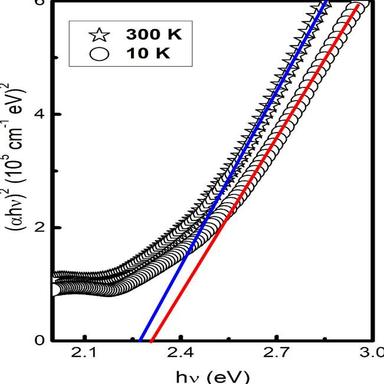
(αhv) 2 vs hv plot of CZSe thin films for the temperature at 10 and 300 K.